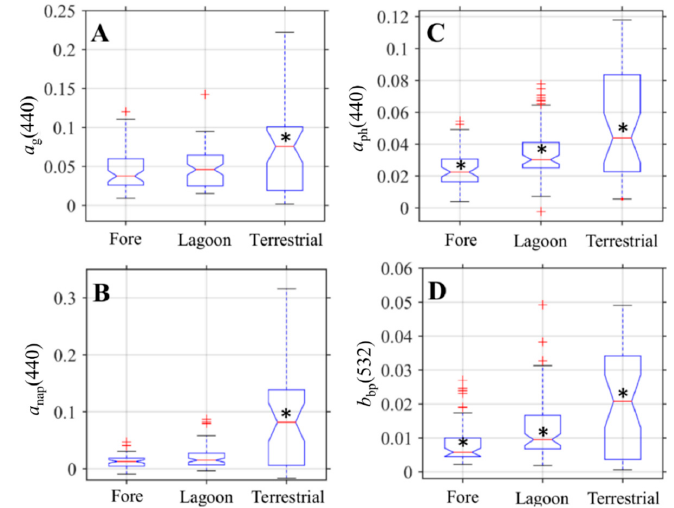
Figure 7. Boxplots showing the variability of the water column optical properties aggregated by three broad geomorphic zones: fore reef (Fore), back reef and lagoon (Lagoon), and fringing and terrestrially-impacted reef (Terrestrial). Properties include: ( A ) absorption by colored dissolved organic matter at 440 nm ( a g ); ( B ) absorption by non-algal particles at 440 nm ( a dg ); ( C ) absorption by phytoplankton at 440 nm ( a ph ); and ( D ) particulate backscattering at 532 nm ( b bp ). Starred values indicate that the values were significantly different ( p < 0.05) in paired tests with the other two zones.